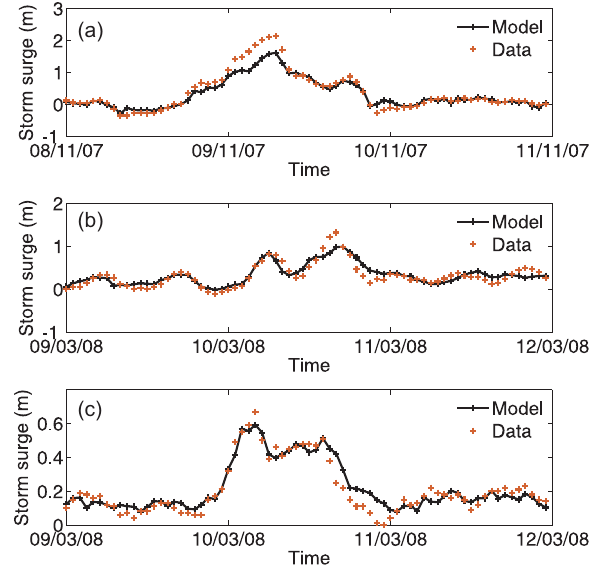
Table 1. Observed and modelled 0.5, 1 and 2-yr return period storm